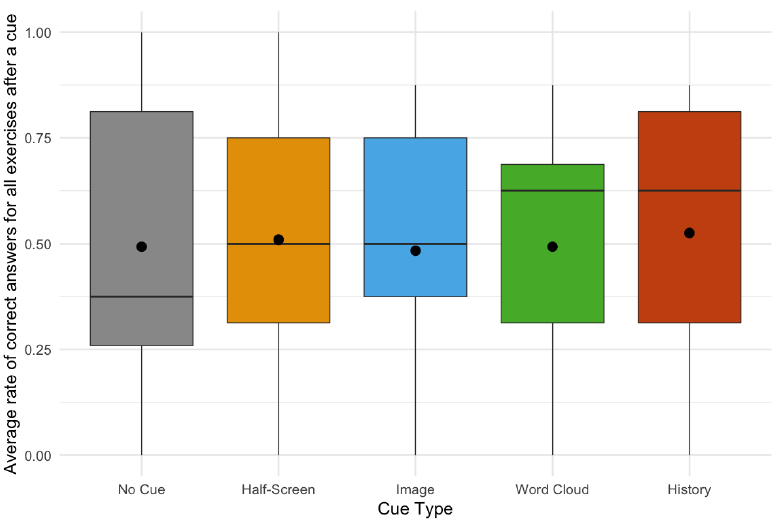
Figure 7. Performance after an